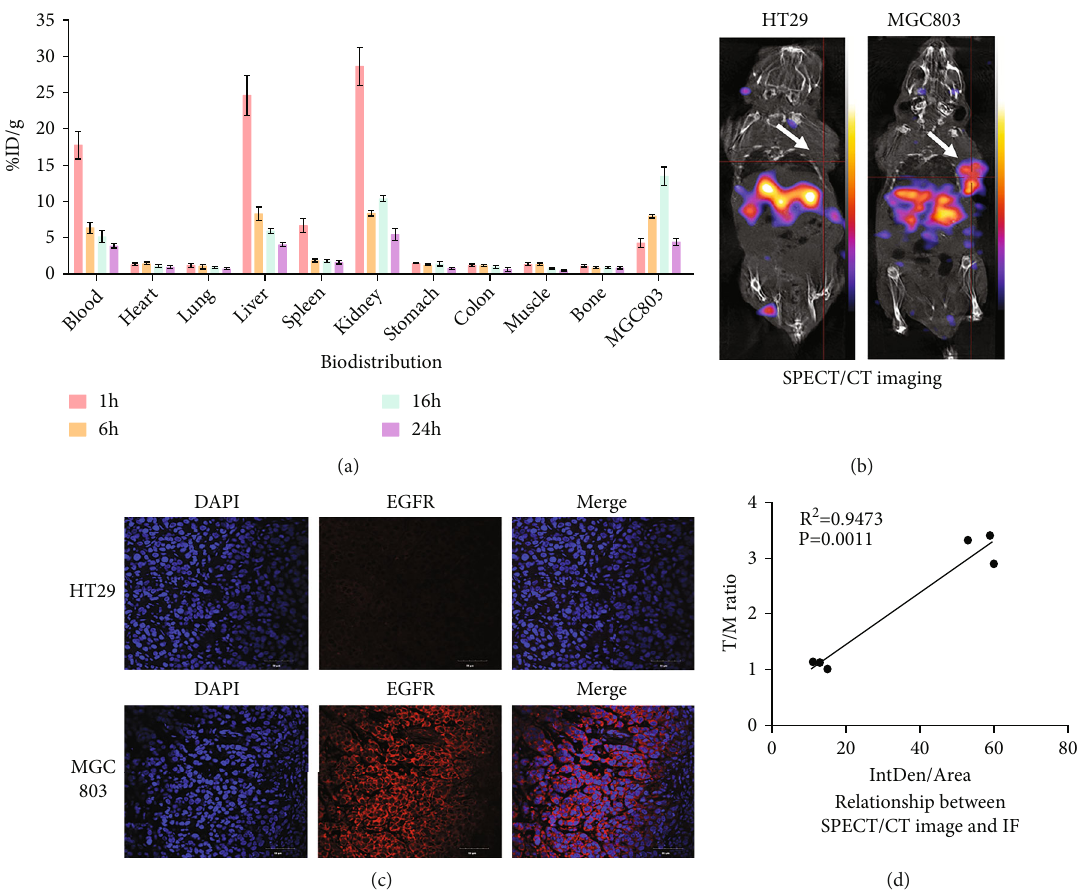
Figure 6: In vitro biodistribution and SPECT/CT imaging. (a) Biodistribution assay demonstrating that 99m Tc-MAG MGC803 tumors peaked at 16 h after injection. (b) 99m Tc-MAG uptake between an MGC803 tumor and a HT29 tumor (arrow). (c) Immuno fl uorescence showing the higher EGFR expression in MGC803 tumor slices compared with HT29 tumor slices. (d) Relationship between SPECT/CT image and immuno fl